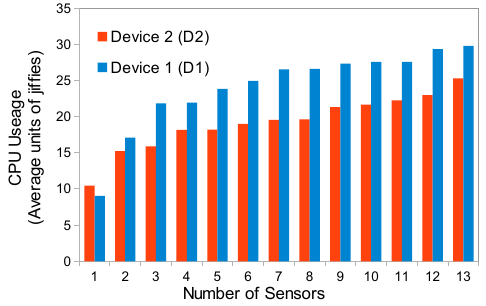
Figure 8. Comparison of CPU Usage by MOSDEN Client - Sensing